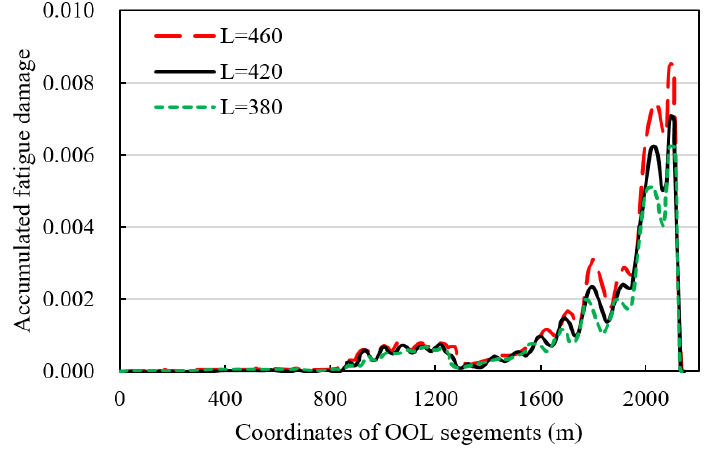
Figure 14. Fatigue damage of OOL with different coverage length of buoyancy material.